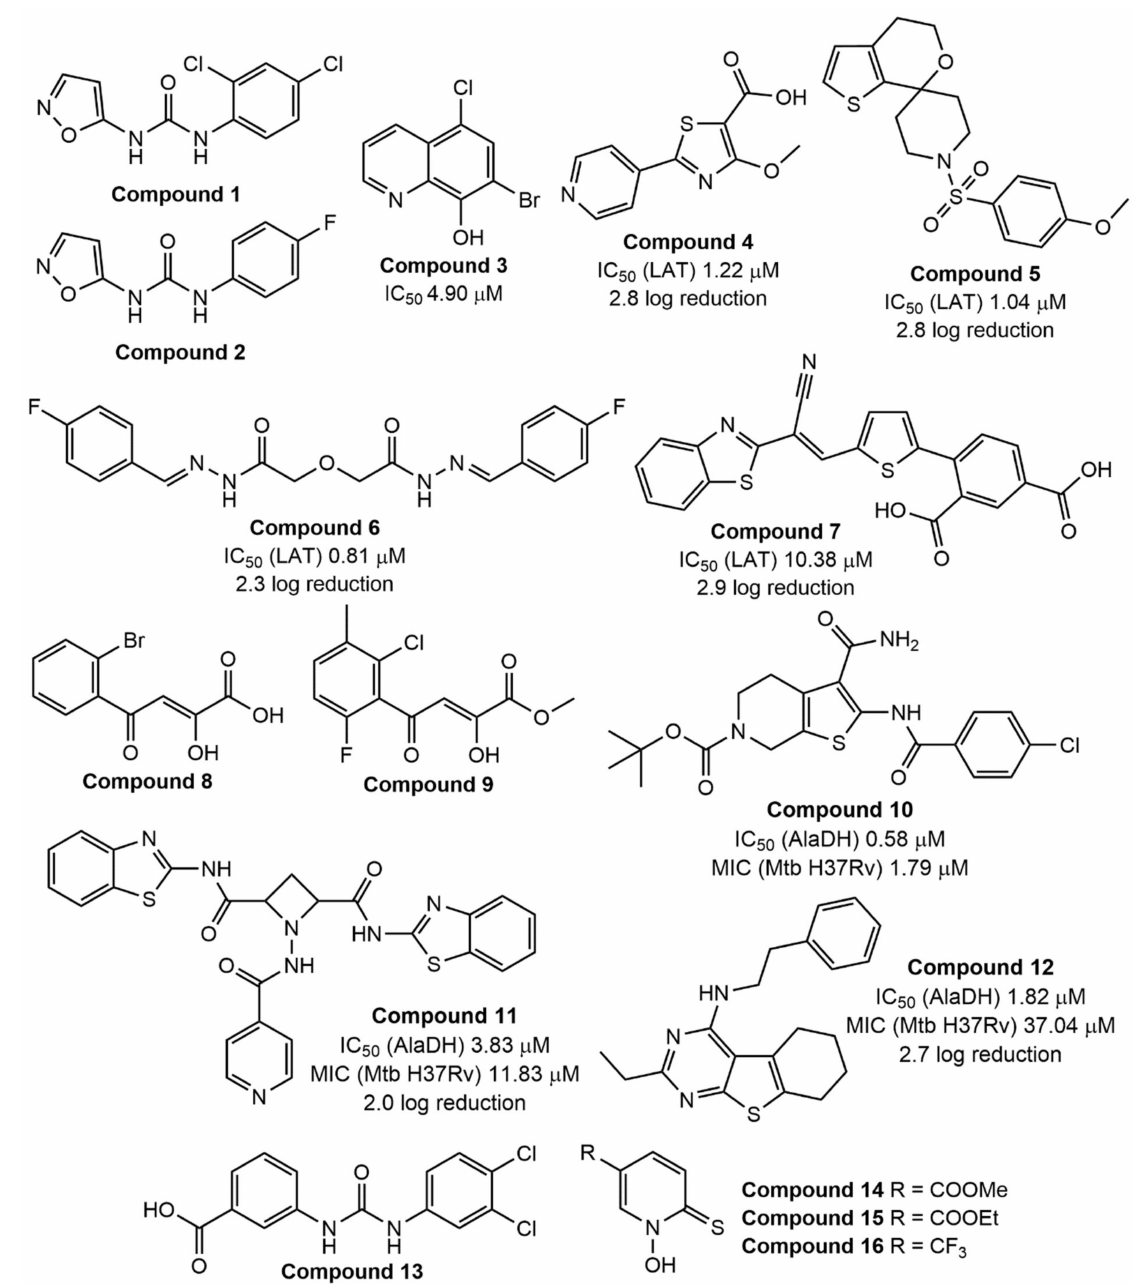
Figure 1. Early-stage small molecules with established drug targets for dormant M. tuberculosis . Compound 1: 1-(2,4-dichlorophenyl)-3-(isoxazol-5-yl)urea; compound 2: 1-(4-fluorophenyl)-3-(isoxazol-5-yl)urea; compound 3: 7-bromo-5-chloroquinolin-8-ol; compound 4: 4-methoxy-2-(pyridin-4-yl)thiazole-5-carboxylic acid; compound 5: 1-((4-methoxyphenyl)sulfonyl)-4 (cid:48) ,5 (cid:48) -dihydrospiro[piperidine-4,7 (cid:48) -thieno[2 ,3- c ]pyran]; compound 6: 2,2 (cid:48) -oxybis( N (cid:48) - (4-fluorobenzylidene)acetohydrazide); compound 7: 4-(5-(2-(benzo[ d ]thiazol-2-yl)-2-cyanovinyl)thiophen-2- yl)isophthalic acid; compound 8: 4-(2-bromophenyl)-2-hydroxy-4-oxobut-2-enoic acid; compound 9: methyl ester of -4-(2-chloro-6-fluoro-3-methylphenyl)-2-hydroxy-4-oxobut-2-enoic acid; compound 10: tert -butyl ester of 3-carbamoyl-2-(4-chlorobenzamido)-4,7-dihydrothieno[2,3- c ]pyridine-6(5 H )-carboxylic acid; compound 11: N 2 , N 4 - bis(benzo[ d ]thiazol-2-yl)-1-(isonicotinamido)azetidine-2,4-dicarboxamide; compound 12: 2-ethyl- N -phenethyl-5,6,7,8- tetrahydrobenzo[4,5]thieno[2,3- d ]pyrimidin-4-amine; compound 13: 3-(3-(3,4-dichlorophenyl)ureido)benzoic acid; com- pound 14: methyl ester of 1-hydroxy-6-thioxo-1,6-dihydropyridine-3-carboxylic acid; compound 15: ethyl ester of 1-hydroxy- 6-thioxo-1,6-dihydropyridine-3-carboxylic acid; compound 16: 1-hydroxy-5-(trifluoromethyl)pyridine-2(1 H